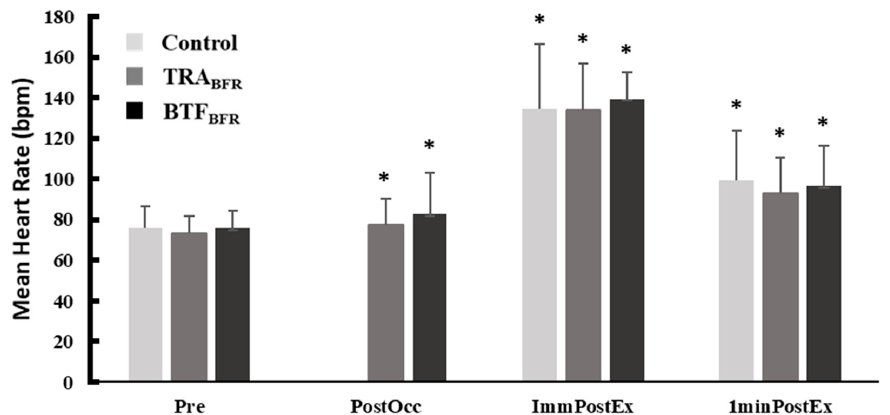
Figure 3. Heart rate in each condition across different time points (M ± SD). No post-occlusion HR data exists for the CON condition, as no occlusion was applied. * = Significant from pre-measurement. TRA BFR = traditional blood flow restriction; BTF BFR = band tissue flossing. Statistical significance is noted at an alpha level of p < 0.05.